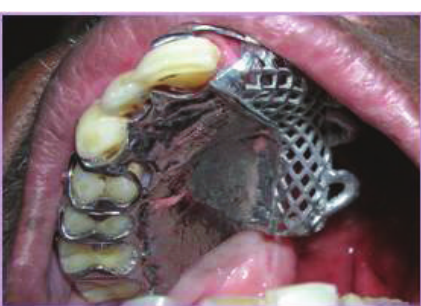
Figure 4: Insertion of the